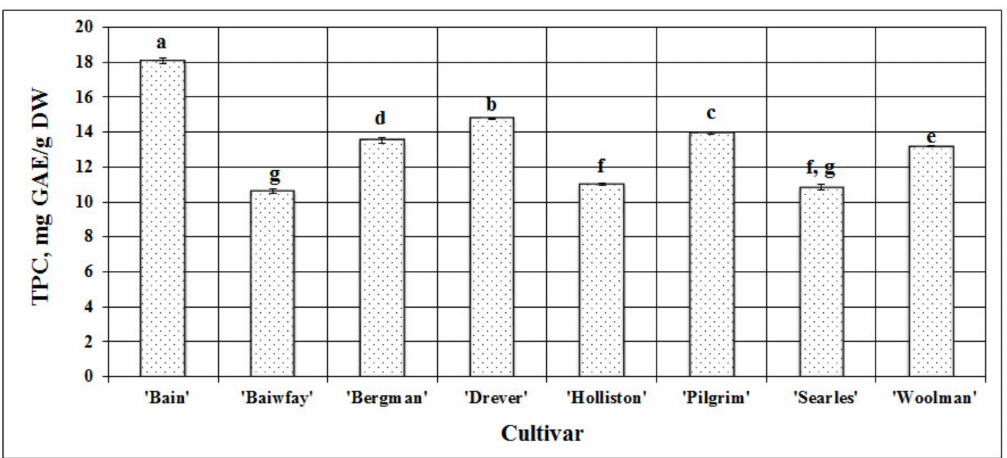
Figure 1. Variability in the total amount of phenolic compounds (TPC) in fruit samples of di ff erent American cranberry cultivars; di ff erent letters indicate statistically significant ( p < 0.05) di ff erences between the studied cranberry fruit samples.